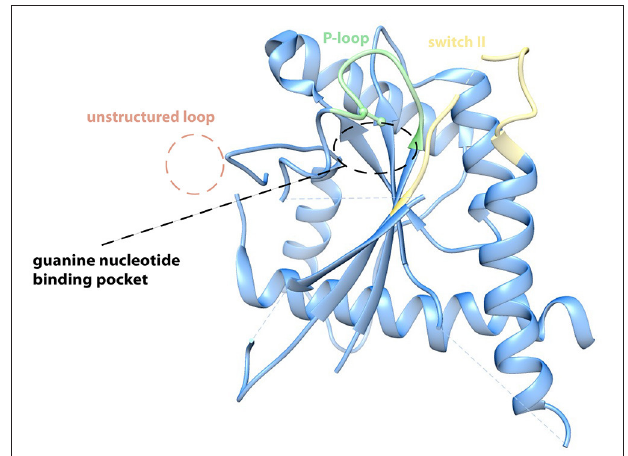
FIGURE 1 | Crystal structure of Cdc11 20 − 298 (PDB-ID 5AR1). The protein crystallized in its apo form. The P-loop, the switch II loop and the anti-parallel ß7–ß8 sheets contribute to the G-binding interface in the human SEPT2 and SEPT7 (Sirajuddin et al., 2007; Zent et al., 2011). In the Cdc11 crystal the ß7–ß8 hairpin is unstructured and points away from the binding interface in a 90 ◦ angle, whereas P-loop (green) and switch II region (yellow) show high similarities. An arginine within the P-loop of Cdc11 possibly hinders effective binding of a nucleotide and thereby possibly explains why Cdc11 is incapable of binding a nucleotide ( Brausemann et al., 2016). Figure created with Chimera vers. 1.10.2. from PDB structure 5AR1.